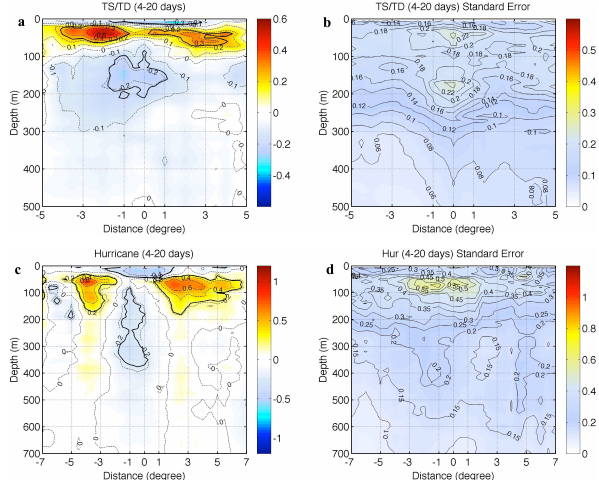
Figure 10. Vertical profile of the 4–20-day averaged ocean ther- mal changes (referenced to pre-storm conditions) from the track center for (a) TS/TD between + 5 and − 5 ◦ and (c) hurricanes be- tween + 7 and − 7 ◦ . The dashed contour interval in black is 0.1 ◦ C for TS/TD and 0.2 ◦ C for hurricanes. The solid black contours de- note the signals that are significant at the 90% confidence interval. (b) and (d) show the standard error of the estimations corresponding to (a) and (c) , respectively. The unit is ◦ C.